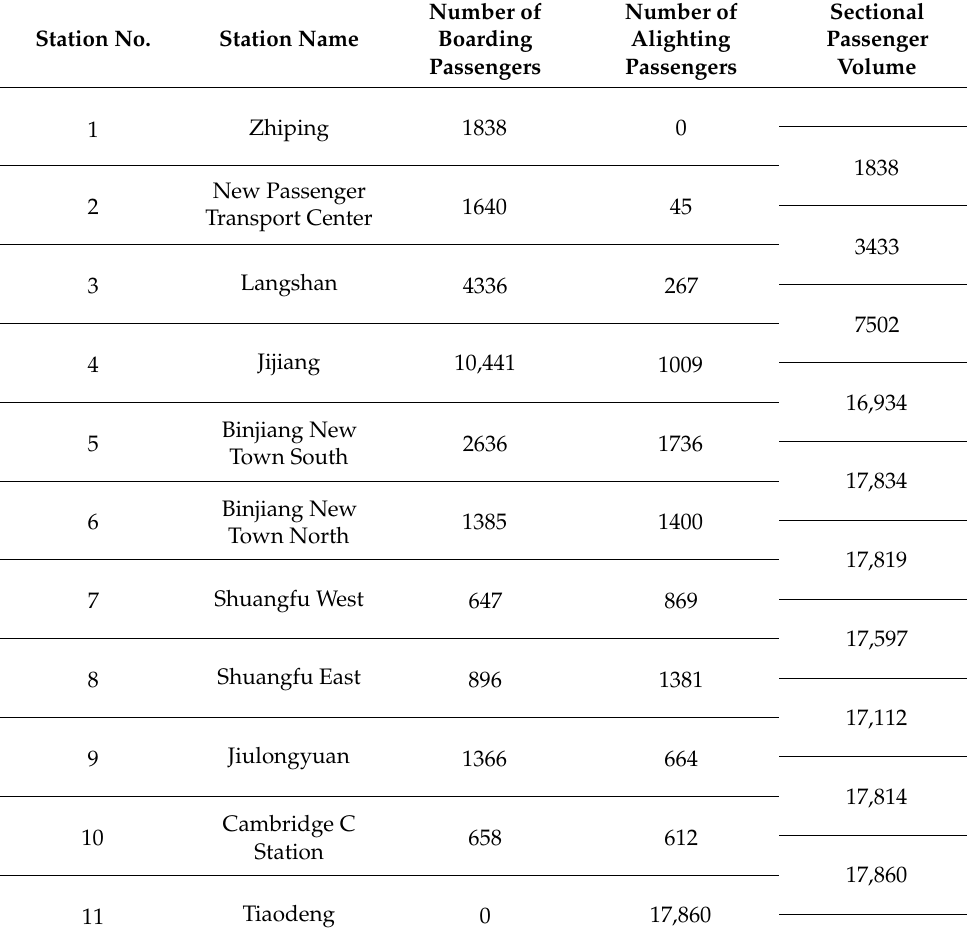
Table 6. Numbers of boarding and alighting passengers at each station and sectional passenger volume on the Jiangjin Line during long-term morning peak hours (unit: persons/h).